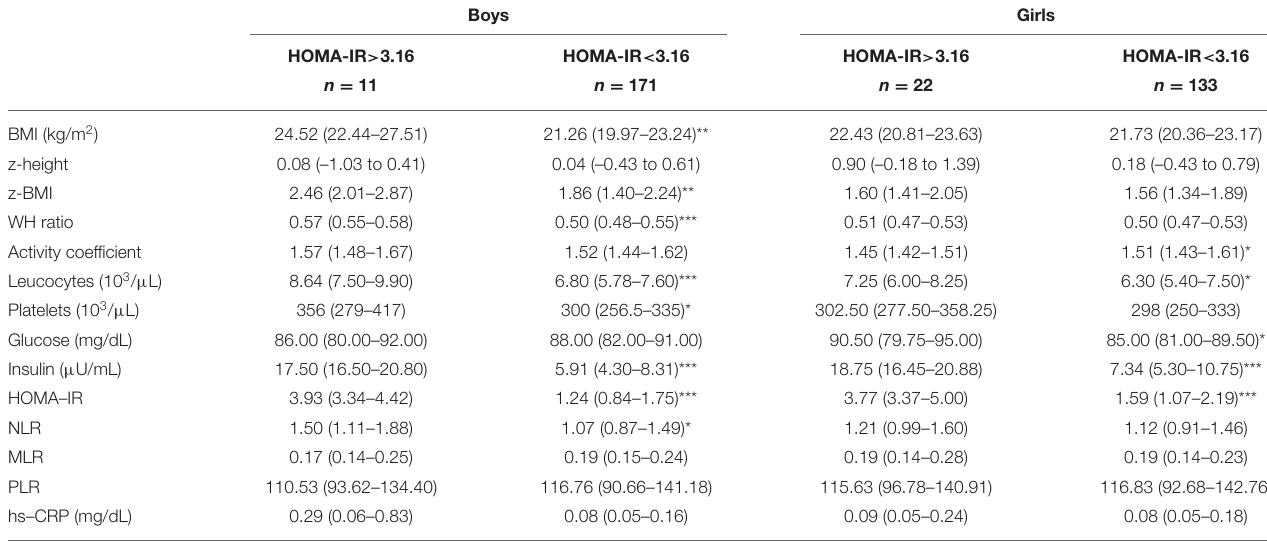
TABLE 2 | Anthropometric, hematological and blood parameters in schoolchildren with overweight/obesity according to HOMA-IR value and sex.